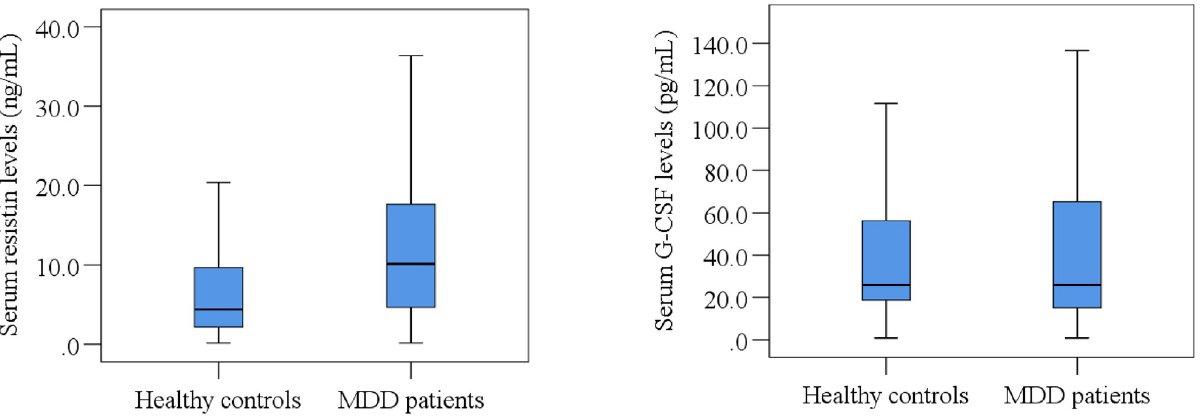
Fig 1. Distribution of serum inflammatory cytokine levels in MDD patients and healthy controls. Boxplot graphs showing the median, maximum and minimum value range.